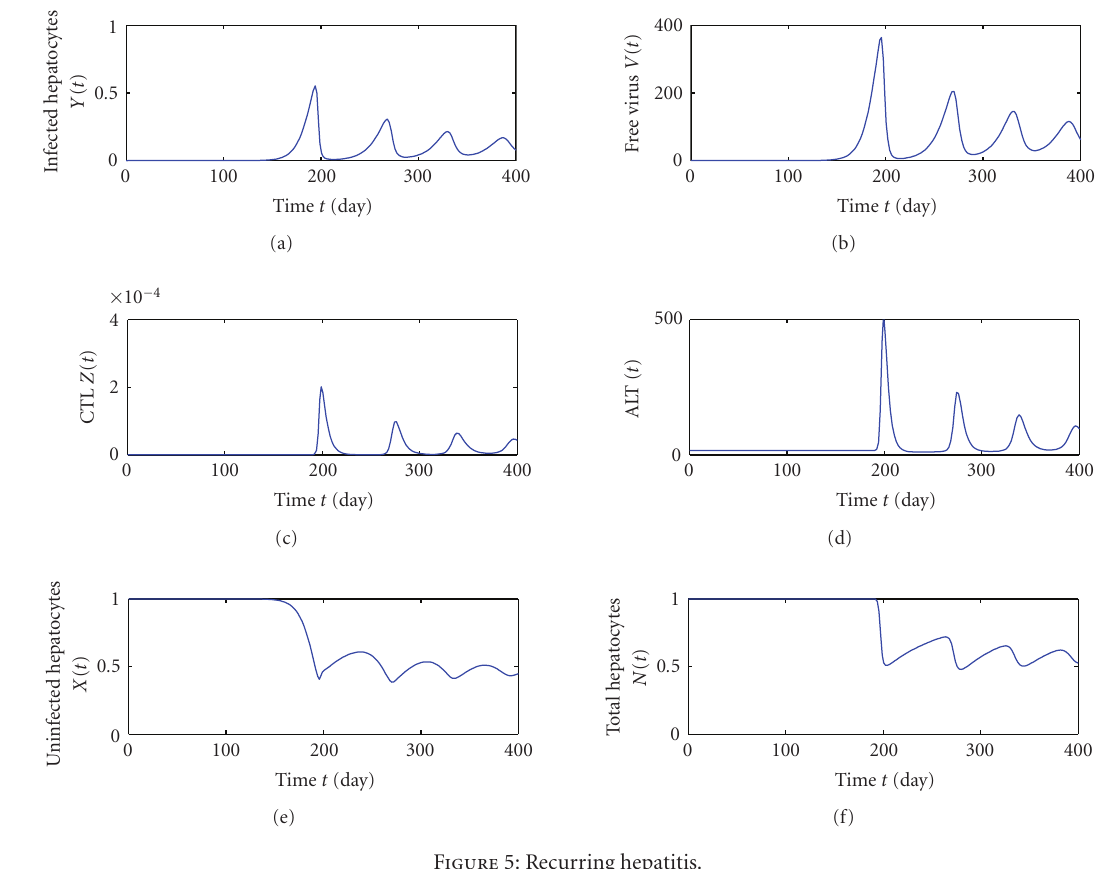
Figure 5: Recurring